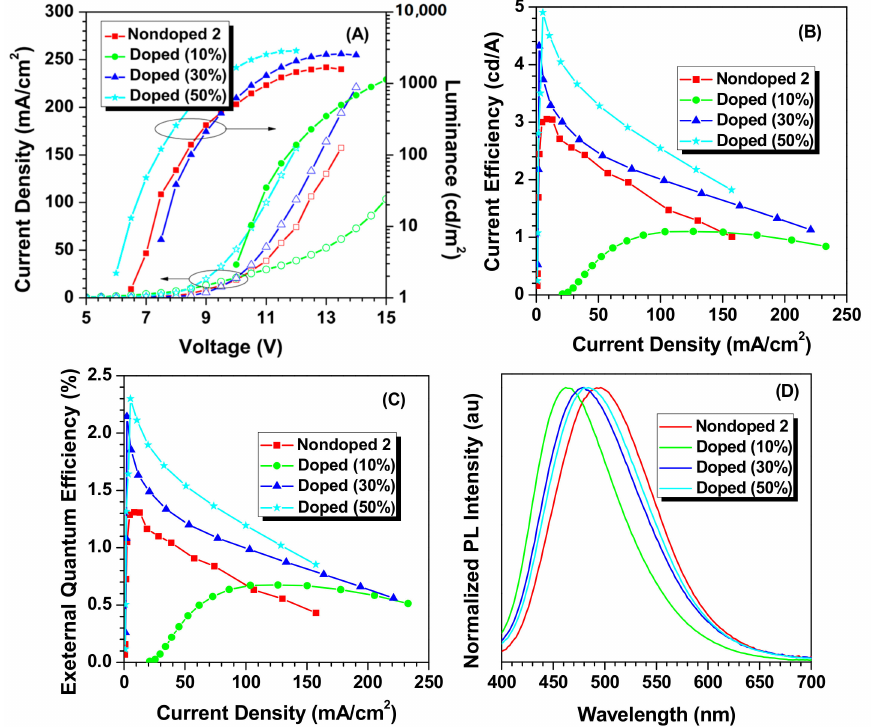
Figure 4. Changes in ( A ) current density and luminance with the applied voltage; ( B ) current